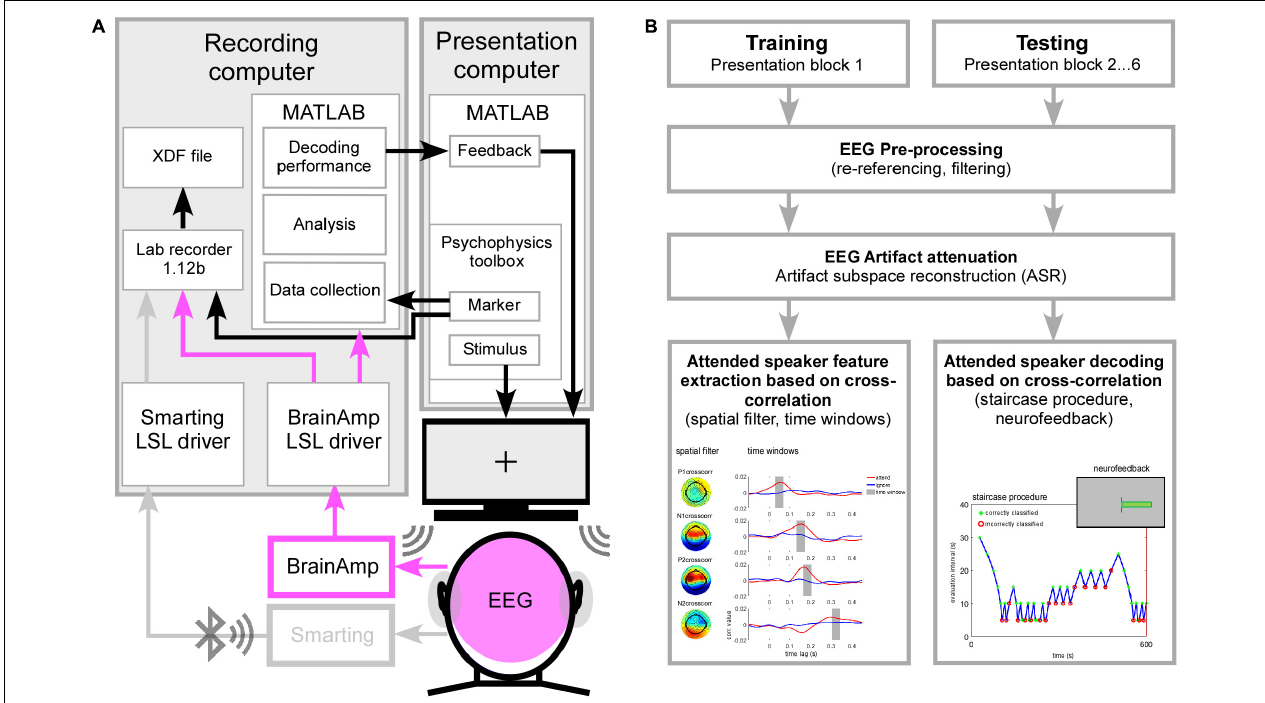
FIGURE 1 | (A) Psychophysics toolbox was used for sound presentation and sending event markers to the Lab recorder and into Matlab on the recording computer. EEG was recorded at 96-channel high density cap (pink) and one cEEGrid attached around each ear (gray, data not shown here). High density EEG was recorded using the BrainAmp amplifiers physically connected to the recording computer. EEG data and event markers were integrated into one XDF file (extensible data format) by using Lab recorder software. High density EEG data and event marker information were collected and analyzed in Matlab. The derived attended speaker decoding performance was condensed into a feedback value, transmitted to the presentation computer and visually presented to the participant. (B) Schematic illustration of the training and testing procedure. EEG data derived in the training and testing phase underwent similar pre-processing and artifact attenuation. In the training procedure individual features of selective auditory attention were extracted from the cross-correlation function and related to the main positive and negative deflections (P1crosscorr, N1crosscorr, P2crosscorr, and N2crosscorr). For each deflection a spatial filter was determined and applied to the EEG data. The virtual channel time course was again cross-correlated with the attended and ignored speech envelope in order to determine a time window containing the largest attention effect. During the testing procedure spatial filters and corresponding time windows were applied to extract the attention effect based on cross-correlation values. Averaged across the main deflections a positive value indicated a correctly classified trial while a negative value indicated an incorrectly classified trial. Based on the classification outcome in the previous evaluation interval the length of the next evaluation interval was modulated in steps of 5 s to derive individual attended speaker decoding profiles. Condensed neurofeedback was presented as a visual bar at the end of each testing